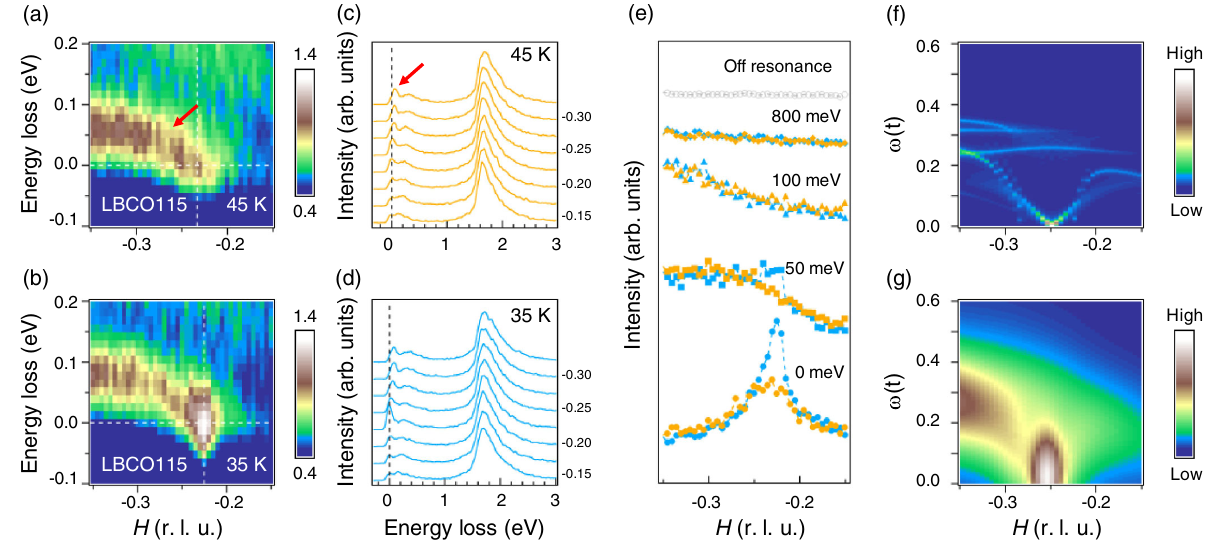
FIG. 2. Two-stage CDW correlations. (a) and (b) show RIXS intensity maps of LBCO115 in a wide momentum transfer range at 45 and 35 K, respectively. Note that the color scales are nearly 10 times smaller than in Fig. 1(d). Representative constant Q cuts of (a) and ¼ 0 , 50, 100, and 800 meV are shown in (e). The (b) are shown in (c) and (d), respectively. Constant E cuts of (a) and (b) at E loss loss yellow and cyan colors represent data at 45 and 35 K, respectively. Gray squares represent an off-resonant constant E cut at 0 meV. loss Below 500 meV, due to the dispersive charge and paramagnon excitation, the intensity maximum is shifted to larger Q . At 800 meV, the constant energy cut becomes flat and similar to a nonresonant constant energy cut at zero energy loss. (f) Calculated charge susceptibility along the ð 0 ; 0 Þ → ð − H; 0 Þ direction. The d ¼ 4 stripe phase mode couples with the phonon. (g) The same plot as (f) but convoluted with experimental resolution. The energy axes in (f) and (g) are shown in units of t ≈ 0 . 3